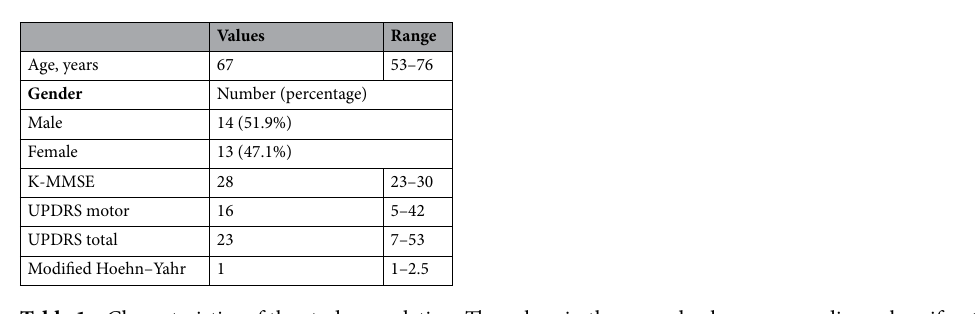
Table 1. Characteristics of the study population. The values in the second column are median values if not specified. K-MMSE Korean-Mini Mental Status Examination, UPDRS Unified Parkinson’s Disease Rating